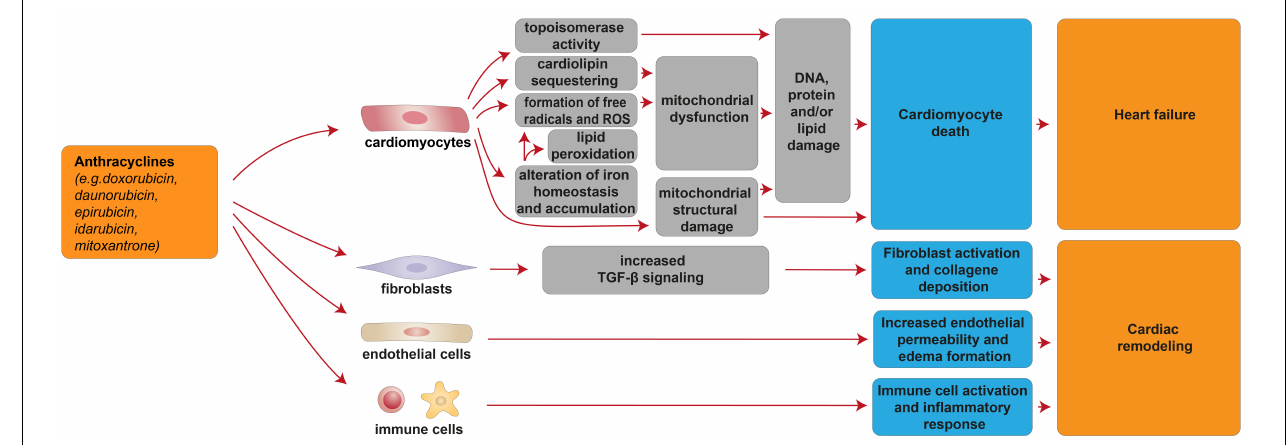
FIGURE 1 | Cellular and molecular mechanisms of the cardiotoxic effects exerted by anthracyclines. Schematic diagram showing the impact of anthracyclines on a multitude of cardiomyocyte-intrinsic mechanisms leading to mitochondrial dysfunction and structural damage and/or DNA damage by topoisomerase activity, in turn leading to cardiomyocyte death and heart failure. Additional mechanisms of anthracycline-induced cardiotoxicity include deregulation of fibroblasts, endothelial, and immune cells, in turn concurring to cardiac